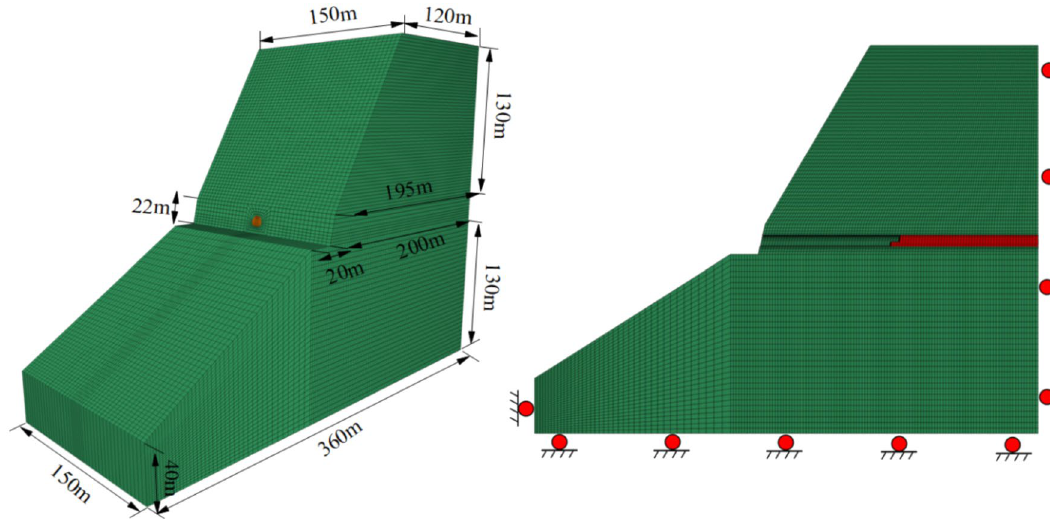
Figure 9. Model size and boundary condition.